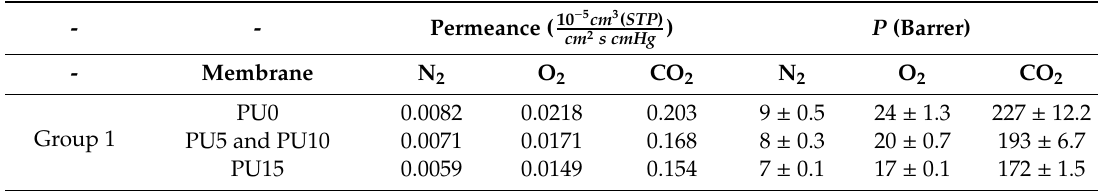
Table 2. N 2 , O 2 , and CO 2 permeances and permeability coe ffi cients ( P ) for the nonporous symmetric membranes PU0, PU5, PU10, and